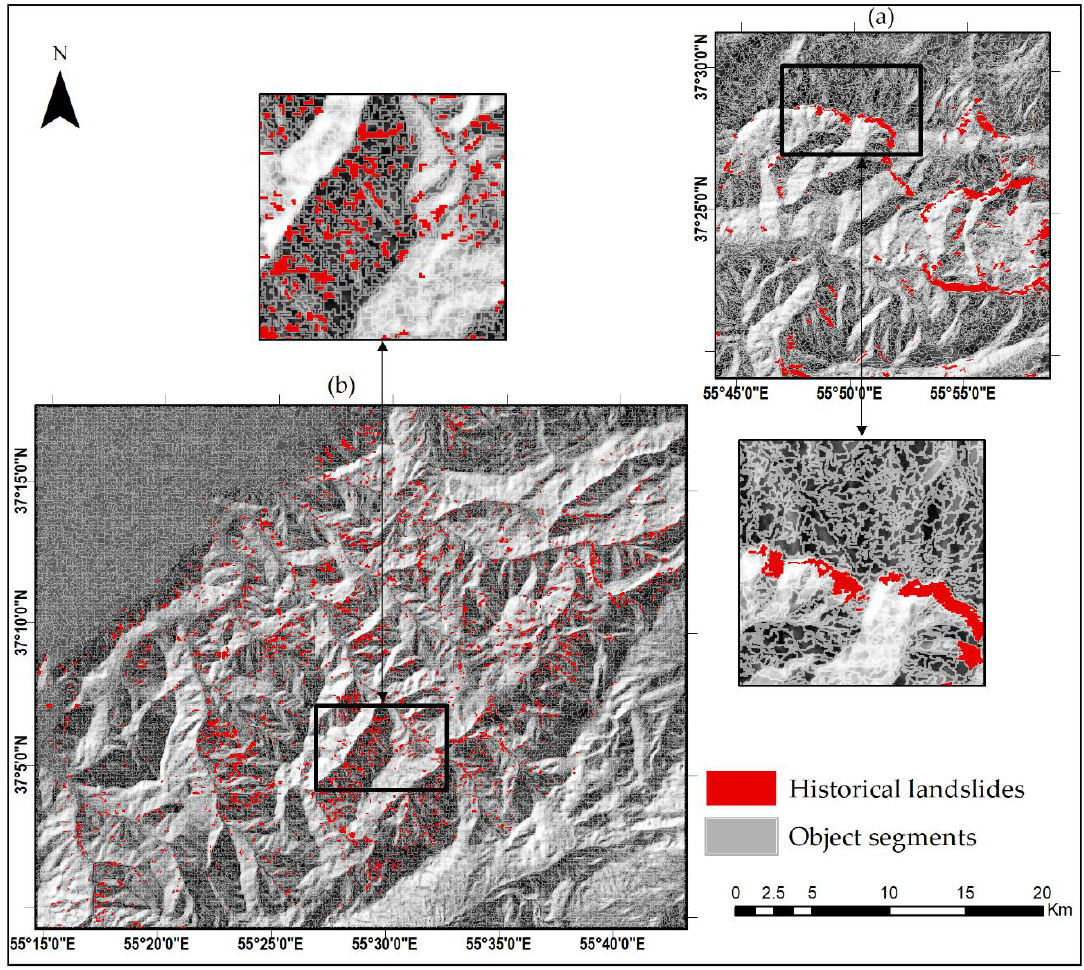
Figure 4. The spatial distribution of derived historical landslides from the top influential object features using object-oriented random forest in the protected forests (old landslides) ( a ), and non-protected forests (new landslides) ( b ), in the Hyrcanian forests, NE Iran.